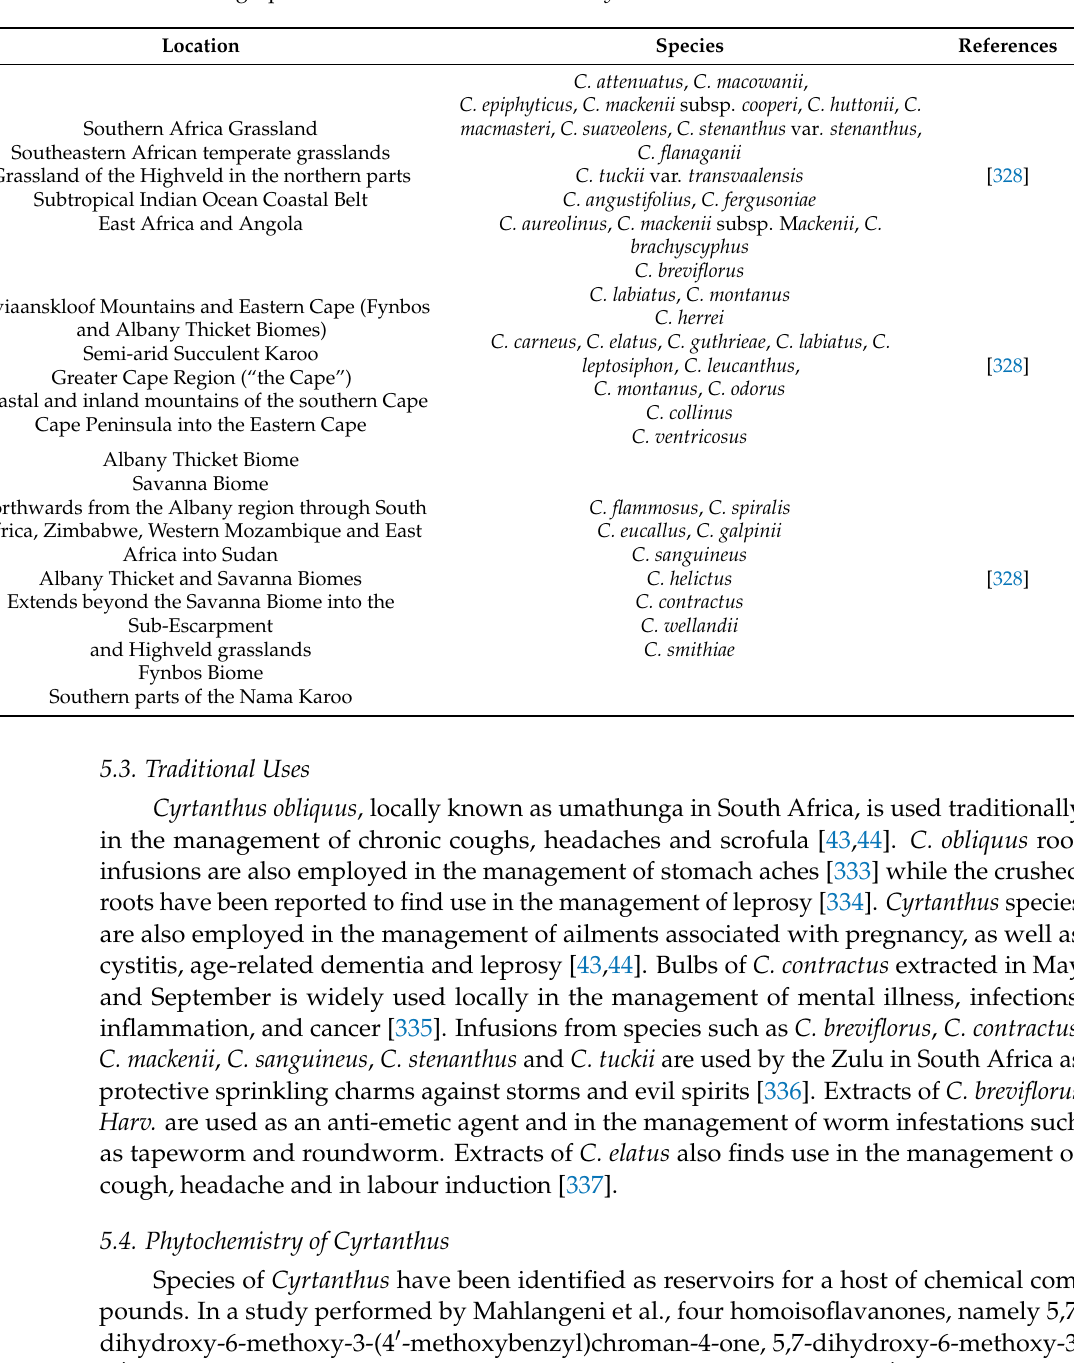
Table 12. Geographical distribution of the Genus Cyrtanthus